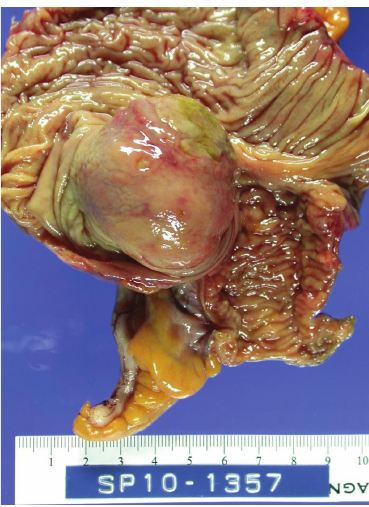
Figure 2: Right hemicolectomy specimen with polypoidal cecal mass.